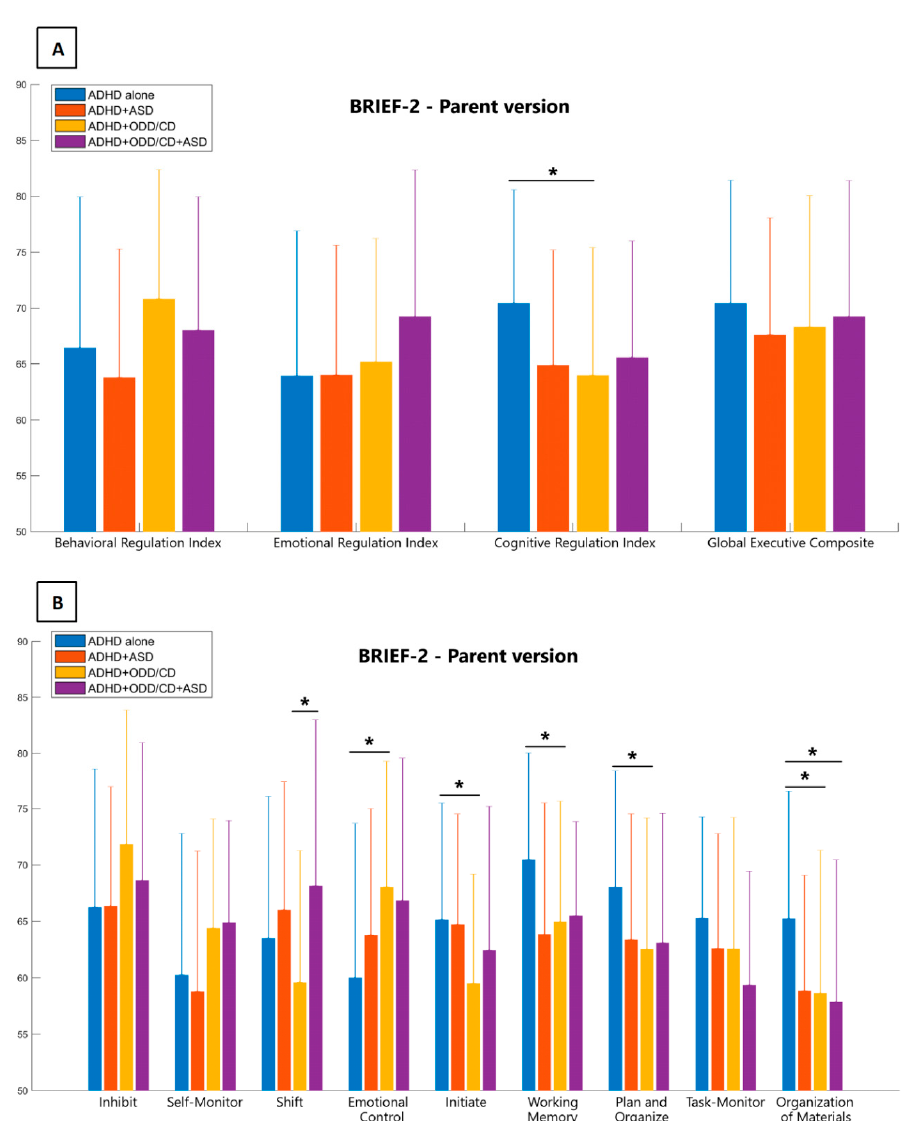
Figure 2. Scores obtained by the four clinical groups in the brief rating inventory of executive functions questionnaire are illustrated: ( A ) global indexes and ( B ) specific subscales are compared ADHD alone group (blue bars), ADHD + ASD group (red bars), ADHD + ODD / CD group (yellow bars), between ADHD alone group (blue bars), ADHD+ASD group (red bars), ADHD+ODD/CD group and ADHD + ASD + ODD / CD group (purple bars). Graphs represent means with standard deviation (yellow bars), and ADHD+ASD+ODD/CD group (purple bars). Graphs represent means with bars. * p -values < standard deviation bars. * p -values < 0.05.